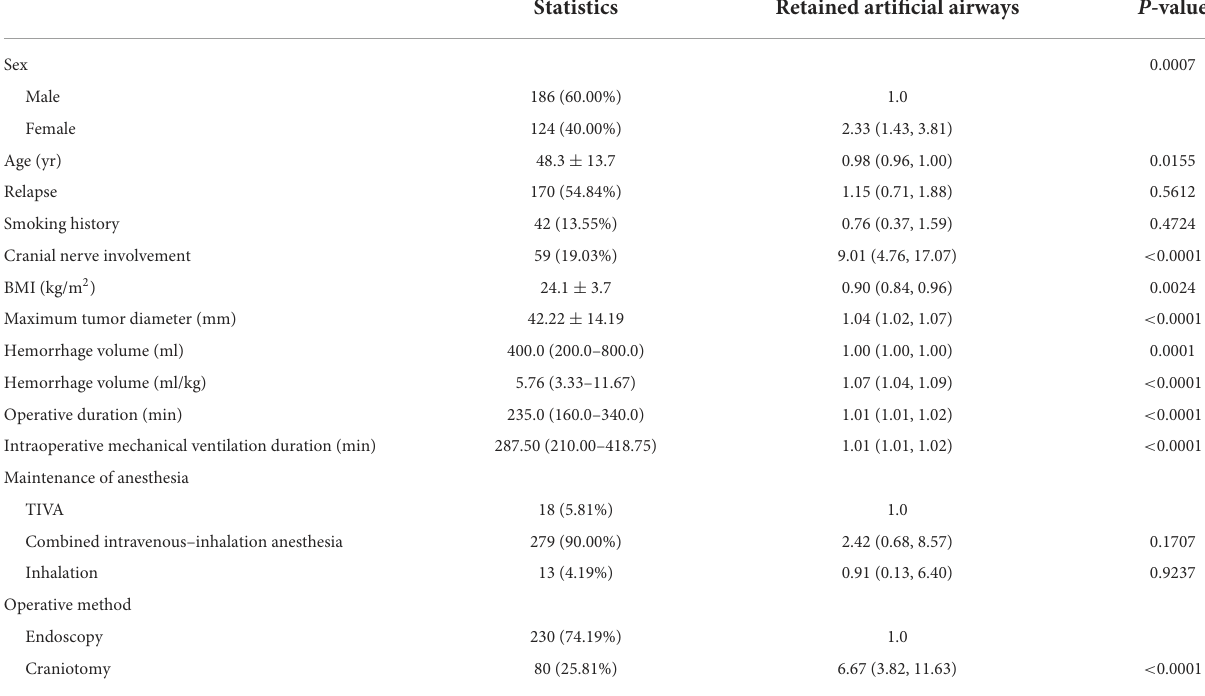
TABLE 3 Univariate analysis for risk factors associated with retained artificial airways.